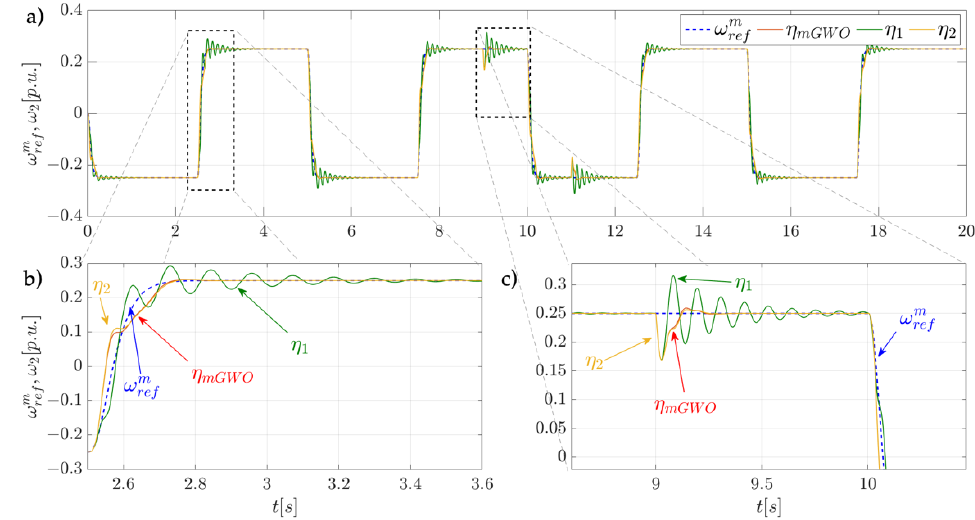
Figure 13. Influence of the learning rate parameter on the adaptation process ( a ), the initial part of the simulation ( b ), applying load torque ( c ).